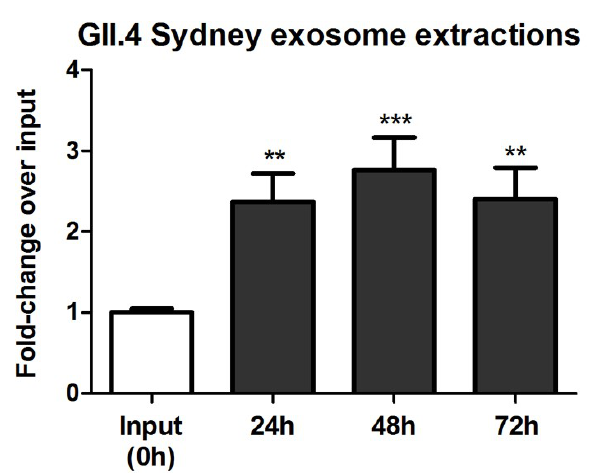
Figure 4. Vero cells are permissive for exosome-associated GII.4 Sydney HuNoV. qRT-PCR analysis of a 3-day time-course. Data represent n = 3 + SEM. ** p < 0.01 and *** p < 0.001.